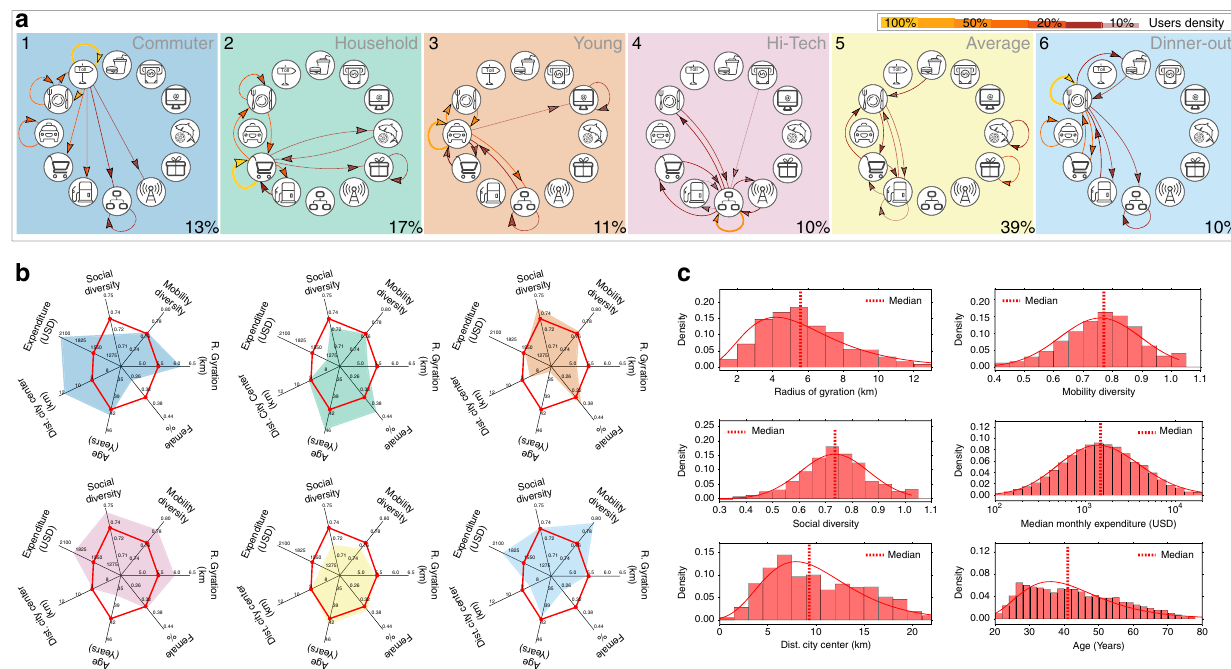
Fig. 4 Identi fi ed lifestyles I. a Groups based on their spending habits. We show the top 10 most frequent spending sequences of the users in each group, representing more than 30% of users ’ shopping routines. The percentage of the total users in each group is shown in the bottom-right corner. b Comparison of the median of socio-demographic variables within each group with respect to the median of all users is in red. (The color of the radar plot identi fi es the spending habits in a .) c Distribution of individual characteristics among users: gender, radius of gyration, mobility diversity, social diversity, median expenditure by month, average distance traveled from the center of residence zipcode to the city center, and age (see Supplementary Figures 11 – 16, 21 for further information). The icons used in this fi gure are work of